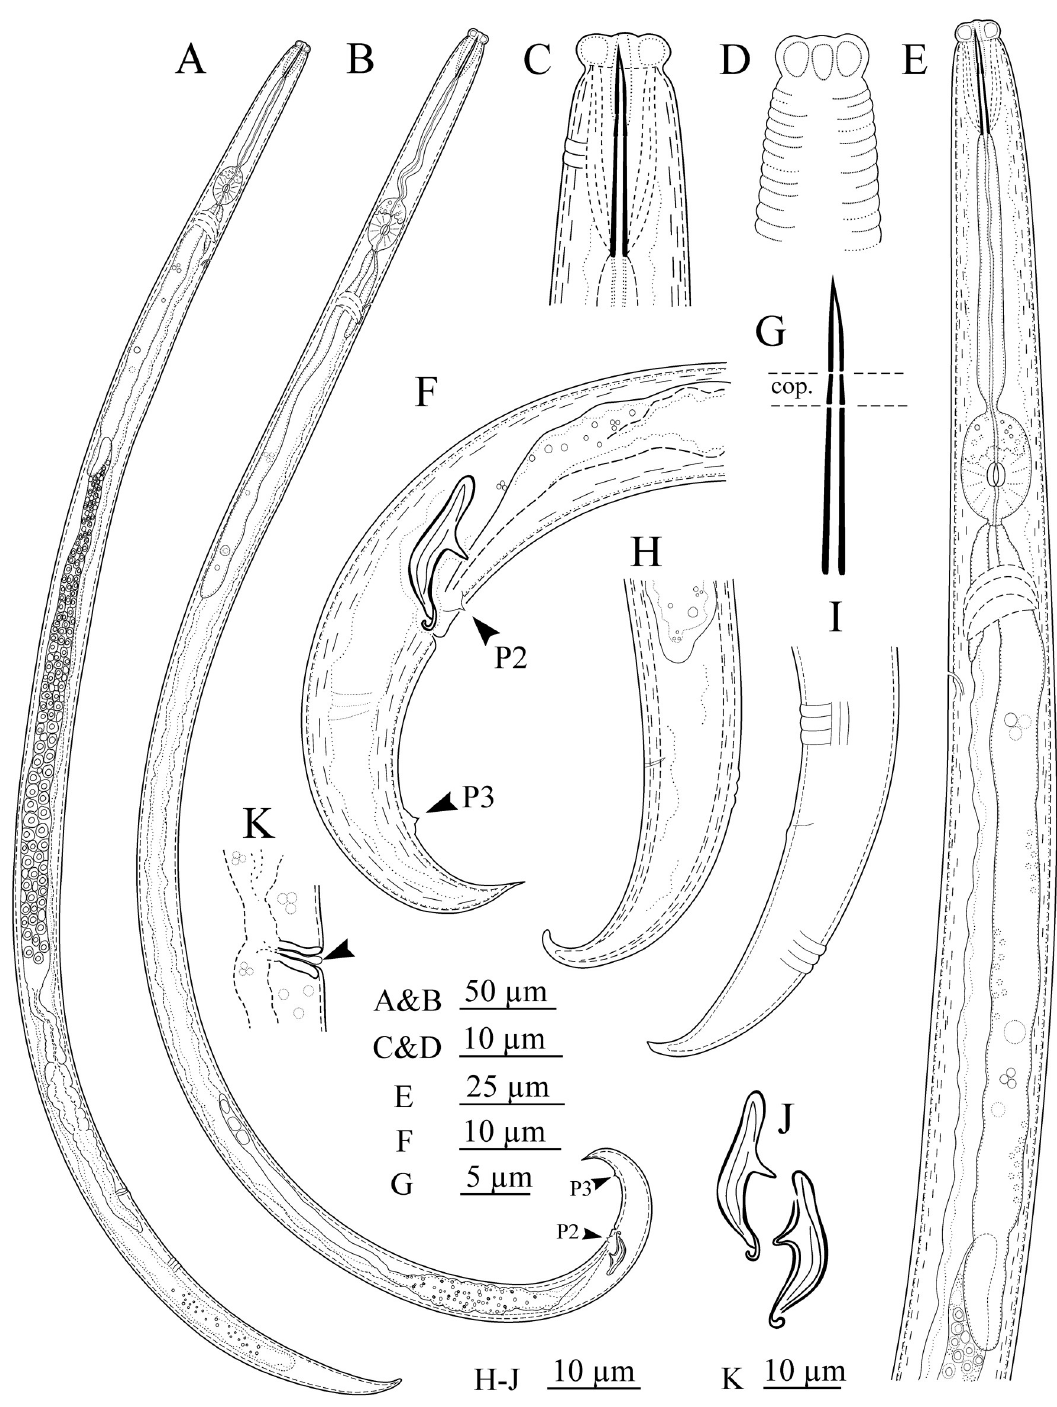
Fig 1. Line drawings of Ektaphelenchus kanzakii n. sp. A&B: Female and male entire body, C&D: Anterior end and corresponding details, E: Pharynx, F: Male posterior body region, G: Stylet structure (cop.: conophore), H&I: Female posterior body end, J: Spicules, K: Epiptygma-like small differentiation